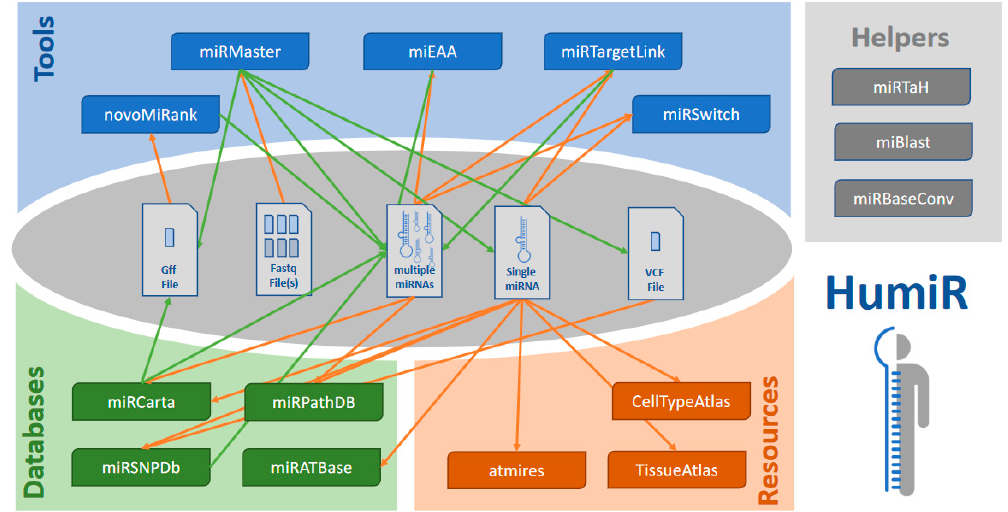
Figure 1. The four classes of tools as well as the respective tools. The middle of the figure presents the different file types, input or output types for the tools. Orange arrows denote a tool input, e.g., NovoMiRank only works with *.gff files. Orange arrows denote an output of a tool. Theoretically, walks through this graph can be generated, following this scheme: a tool gets a file type as input and produces another filetype as output, which in turn is again used as input for the next tool.